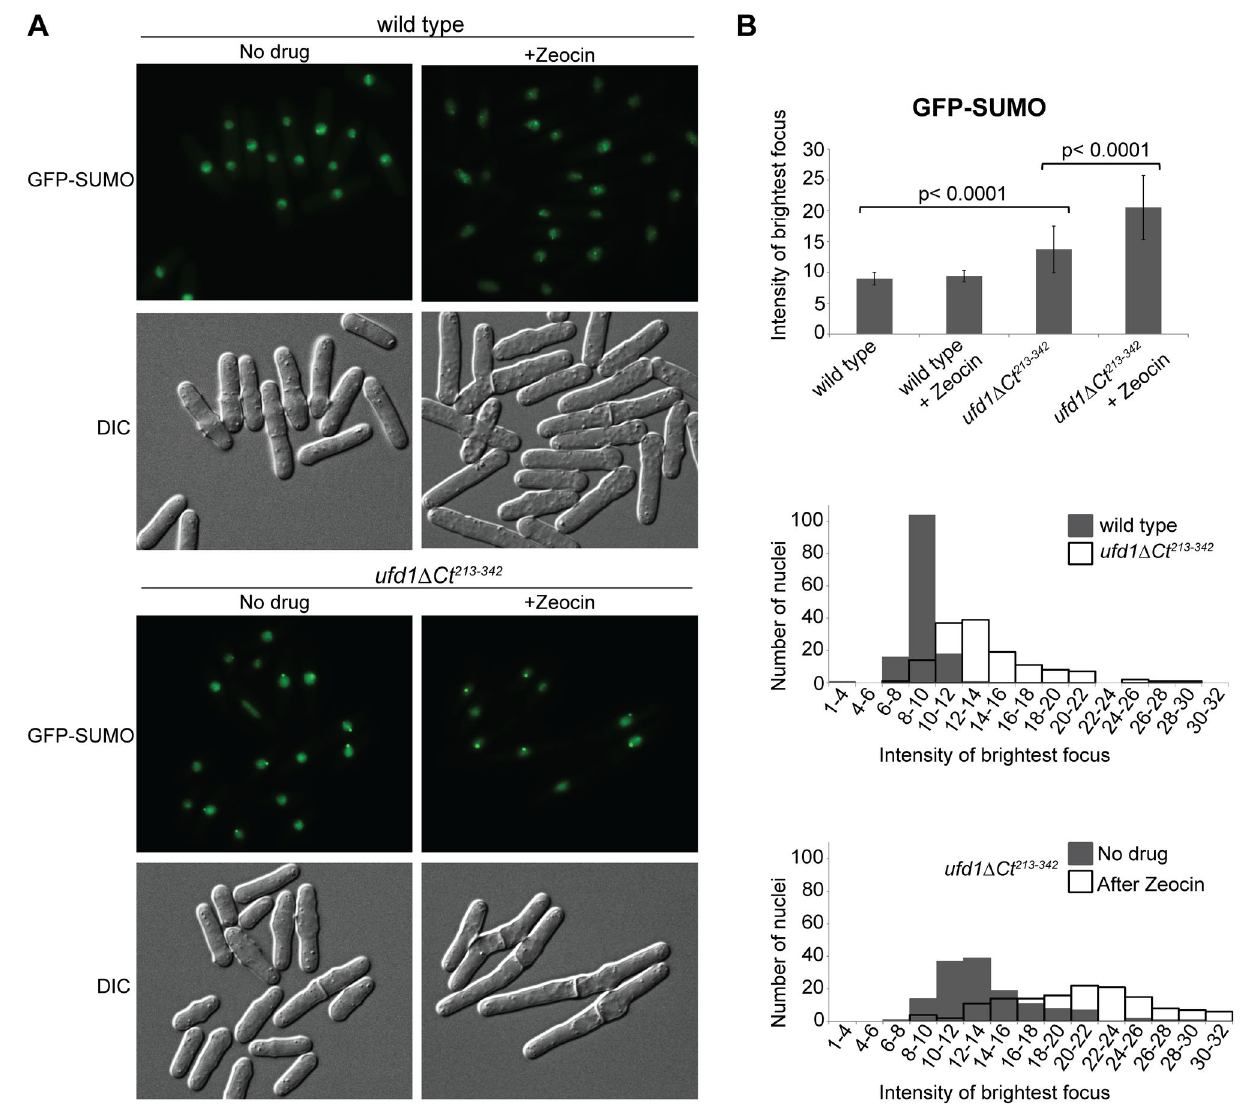
Figure 2. Increased SUMO foci intensity in ufd1ΔCt 213-342 cells. (A) Fluorescence imaging of GFP-SUMO in wild-type and ufd1ΔCt 213-342 cells propagated in the presence or absence of Zeocin (350 µg/ml for 2 1/2 hr). (B) Quantification of GFP-SUMO foci intensity. The intensity of the brightest GFP voxel was measured in > 140 nuclei for each of the strains and conditions shown in (A). Bar graphs in the upper panel display the mean intensities and standard deviations measured in the experiment; histograms in the two lower panels show the distribution of GFP-SUMO intensities. Statistically-significant differences (p ˂ 0.0001) between ufd1ΔCt 213-342 cells and wild type, and between ufd1ΔCt 213-342 cells before and after Zeocin treatment were observed in this experiment and for two replicates of the experiment (not